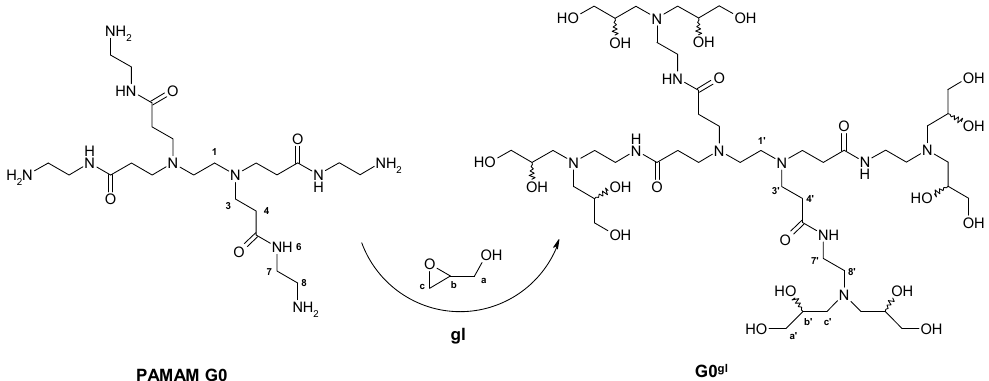
glycidol equivalents.